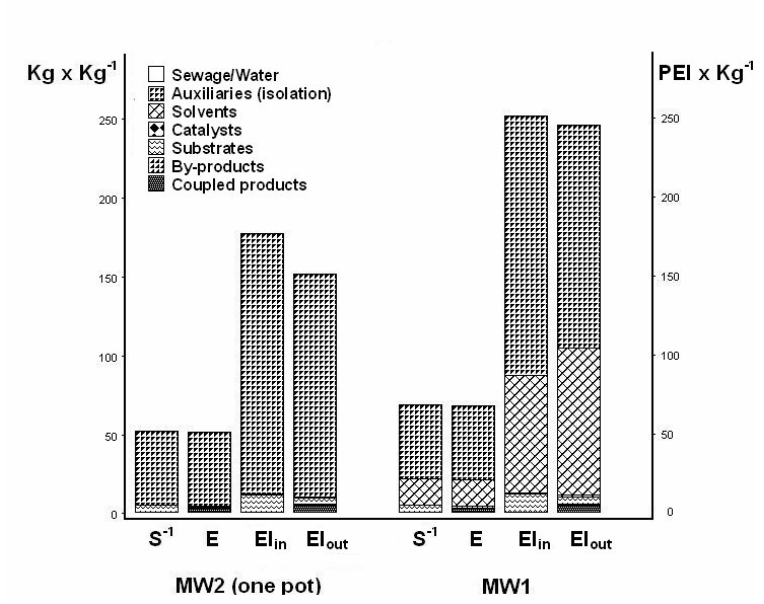
Figure 5. Evaluation histograms of MW mediated solvent-free approaches, MW1 and MW2 (one pot), for the synthesis of compound a . S -1 = inverse selectivity (or mass index). E = environmental factor. EIin and EIout represent respectively S -1 and E weighted in function of the “weighting factors” (costs, risk, human toxicity, ecotoxicology). PEI represents Possible Environmental